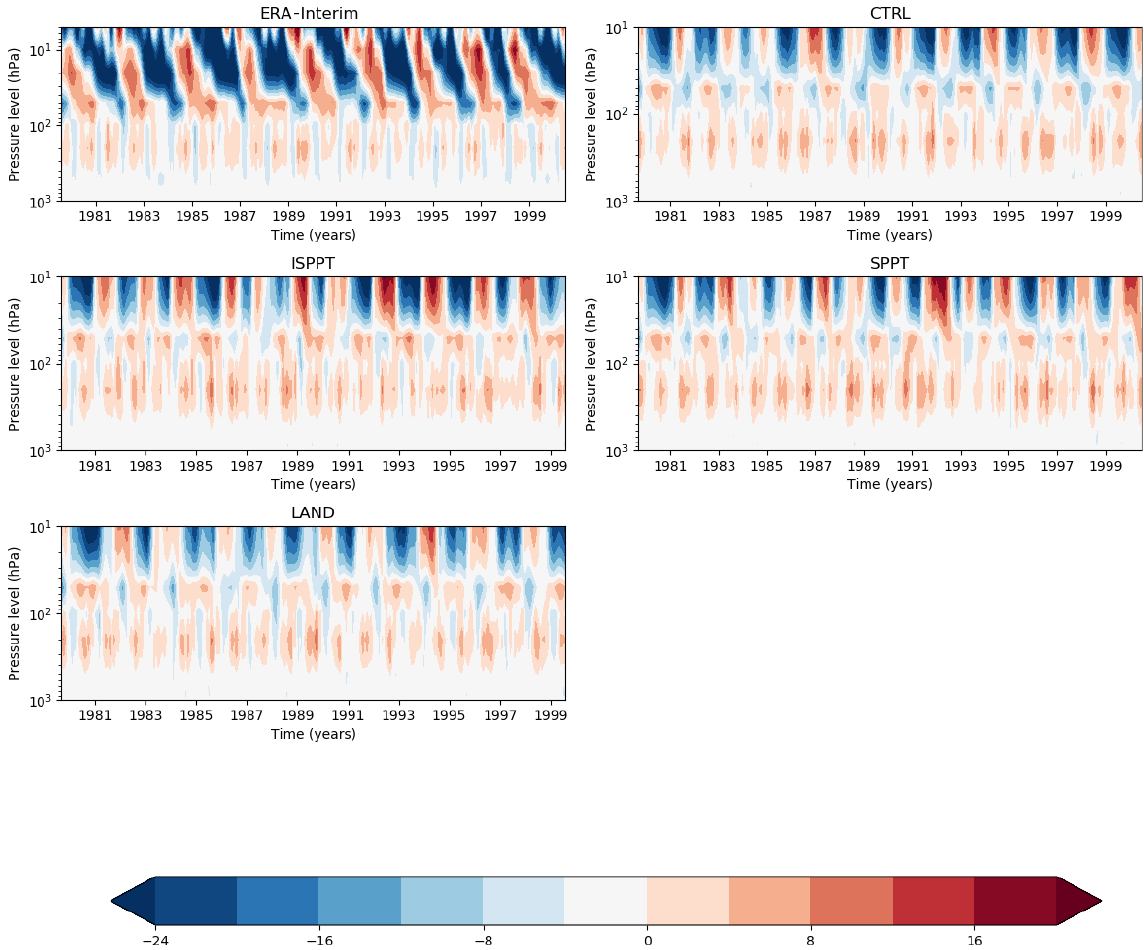
Figure 11. Visualization of the QBO (time–pressure level section of zonal winds between 10 ◦ S and 10 ◦ N with the seasonal mean removed) for the ensemble member covering 1980–2000, the period overlapping the most with ERA-Interim. Pressure levels are plotted according to a logarithmic scale for ease of interpretation. Units are in metres per second (ms − 1